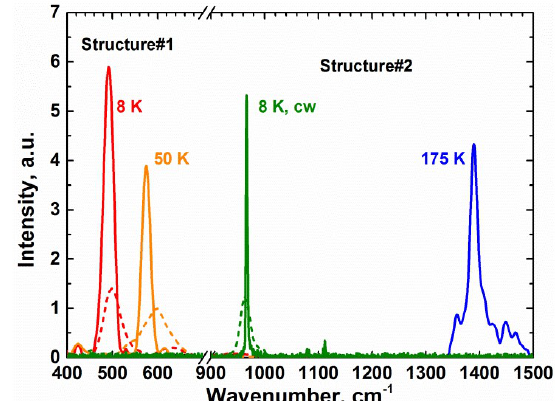
Fig. 1. SE spectra at different temperatures (solid curves) ob- tained under pulsed pumping with 2.3 µm wavelength and 10 kW/cm 2 intensity for Structure #1 (at both temperatures) and 65 kW/cm 2 for Structure #2 at 175K. SE for Structure #2 at T = 8K was obtained at cw excitation with 0.9 µm wavelength 7 W/cm 2 intensity. Dash curves show PL spectra obtained with the same cw pumping source at 5 W/cm 2 intensity for Structure #1 and 1 W/cm 2 for Structure #2 at 8